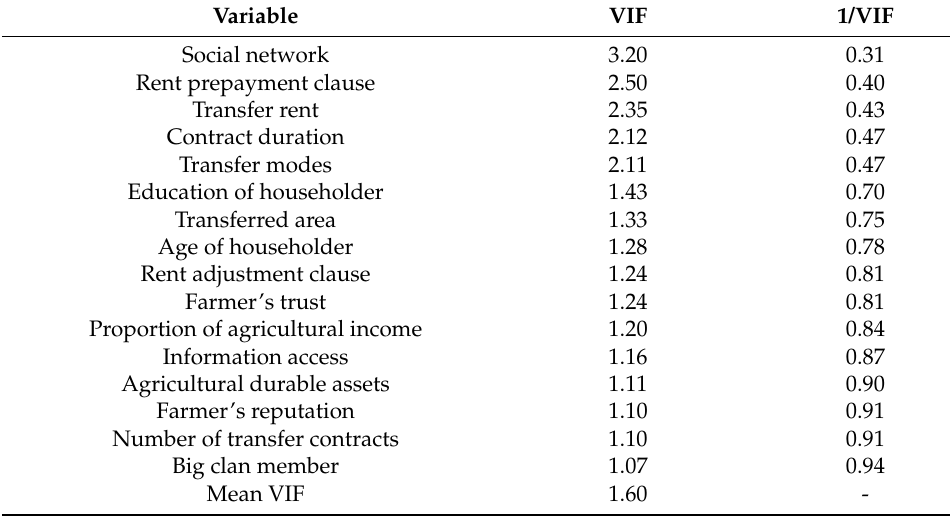
Table A2. VIF of variables.